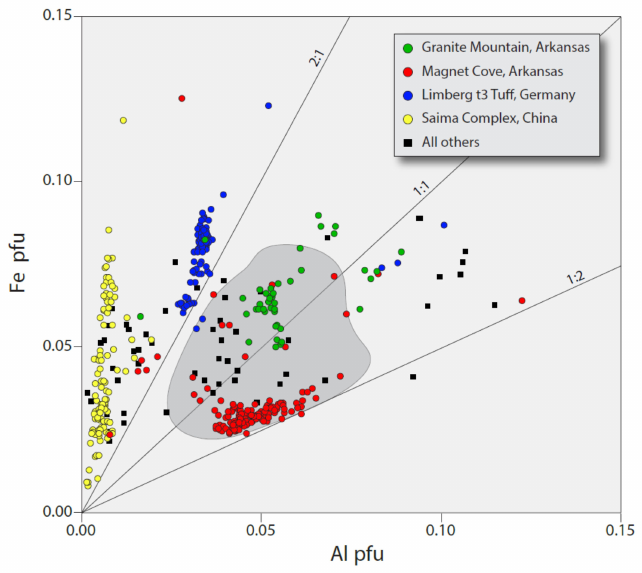
Figure 20. Fe versus Al in titanite from SiO 2 -undersaturated rocks with the four main data sets from Granite Mountain, Arkansas (green), Magnet Cove, Arkansas (red), Limberg t3 Tuff of Kaiserstuhl region, Germany (blue), and Saima alkaline complex, China (yellow), highlighted. Data for Saima complex [77], and for Magnet Cove, Granite Mountain, and Kaiserstuhl (this paper). Shaded area is for 90% of plutonic titanite for